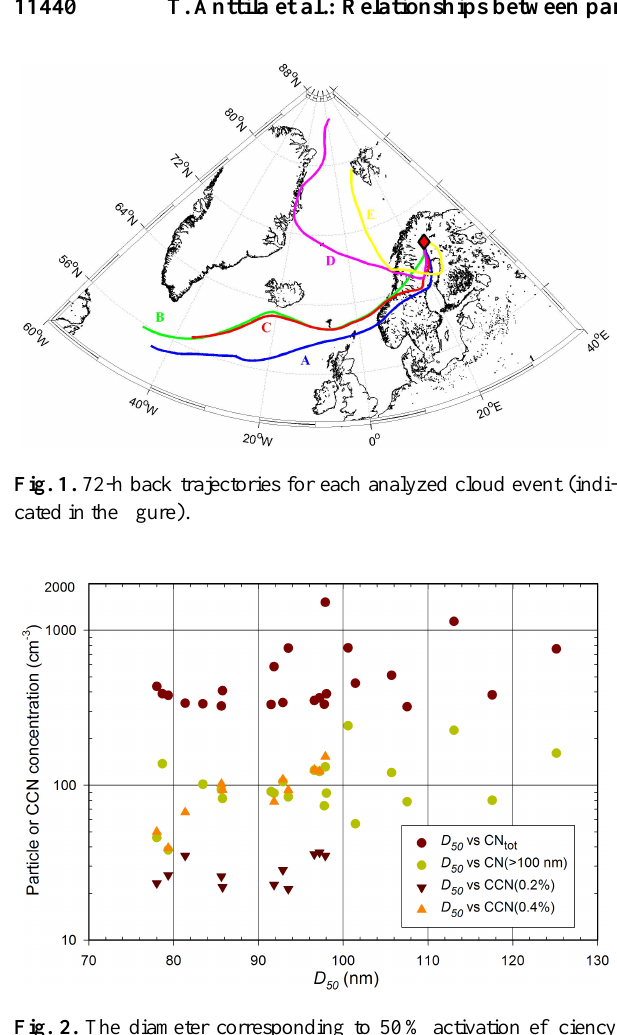
Fig. 2. The diameter corresponding to 50% activation efficiency ( D 50 ) versus particle and CCN concentrations (indicated in the leg- end).